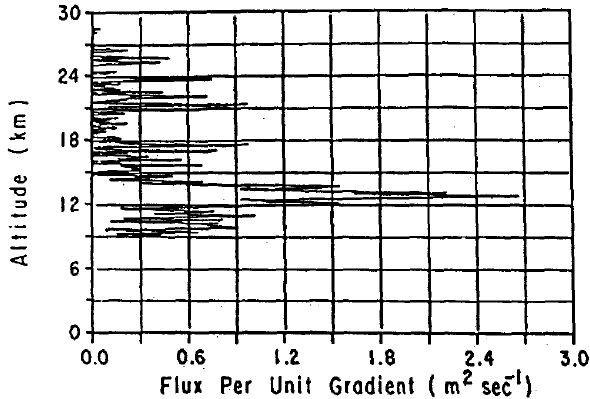
Fig. 9. Development of φ (concentration) as a function of time re- sulting in random mixing layers. The initial φ is a δ function. Com- plete mixing is assumed within the mixing layers (Dewan, 1981).